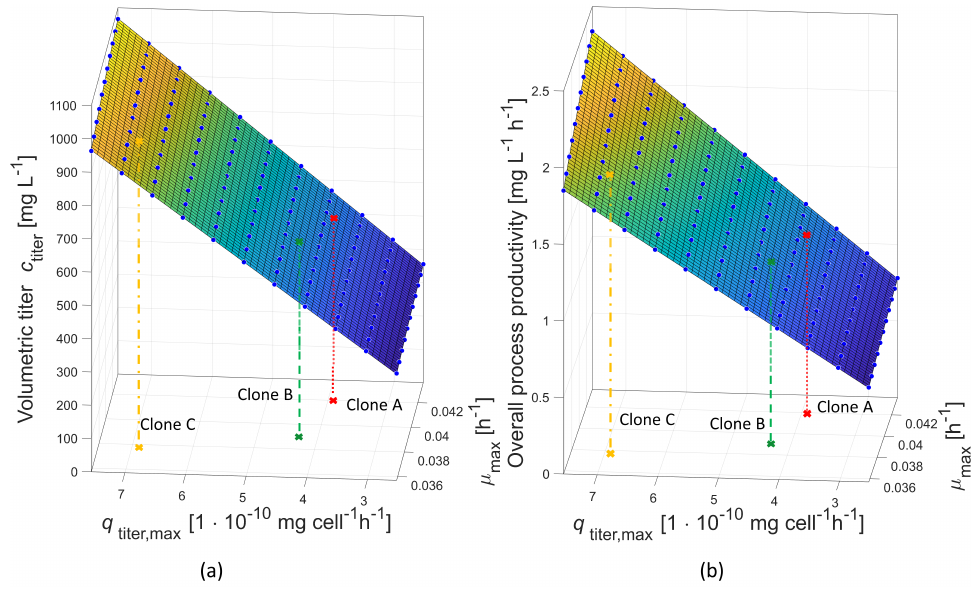
Figure 8. Response surface for volumetric titer after 168 h (7 days) of production over maximum production rate and maximum growth rate ( a ). Overall process productivity (=Space-Time-Yield: volumetric titer after 168 h (7 days) in production/overall cultivation time, including inoculum train) over maximum production rate and maximum growth rate ( b ). The reference clone A (red solid line) and two compared clones, clone B (green dashed line, 7.6% lower µ max and 10.5% higher q titer,max ) and clone C (orange dotted line, 10% lower µ max and 74% higher q titer,max ) are placed in the graphs. Table 8. Results, volumetric titer and overall process productivity (=Space-Time-Yield: volumetric titer after 168 h (7 days) in production/overall cultivation time, including inoculum train) for reference clone A, and two clones to be compared, clone B and clone C. These clones differ in terms of maximum growth rates and maximum production rates, as listed in the corresponding